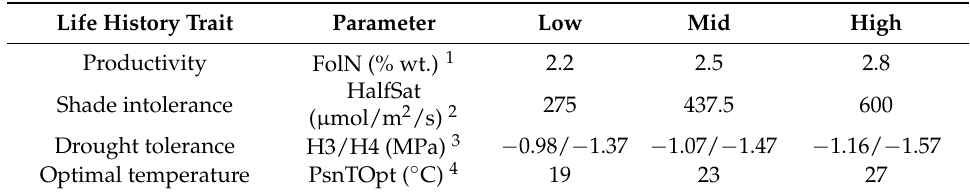
Table 1. Alternative levels of species life history traits used to create random species assemblages for the site-level experiment, as in Gustafson et al. [4].